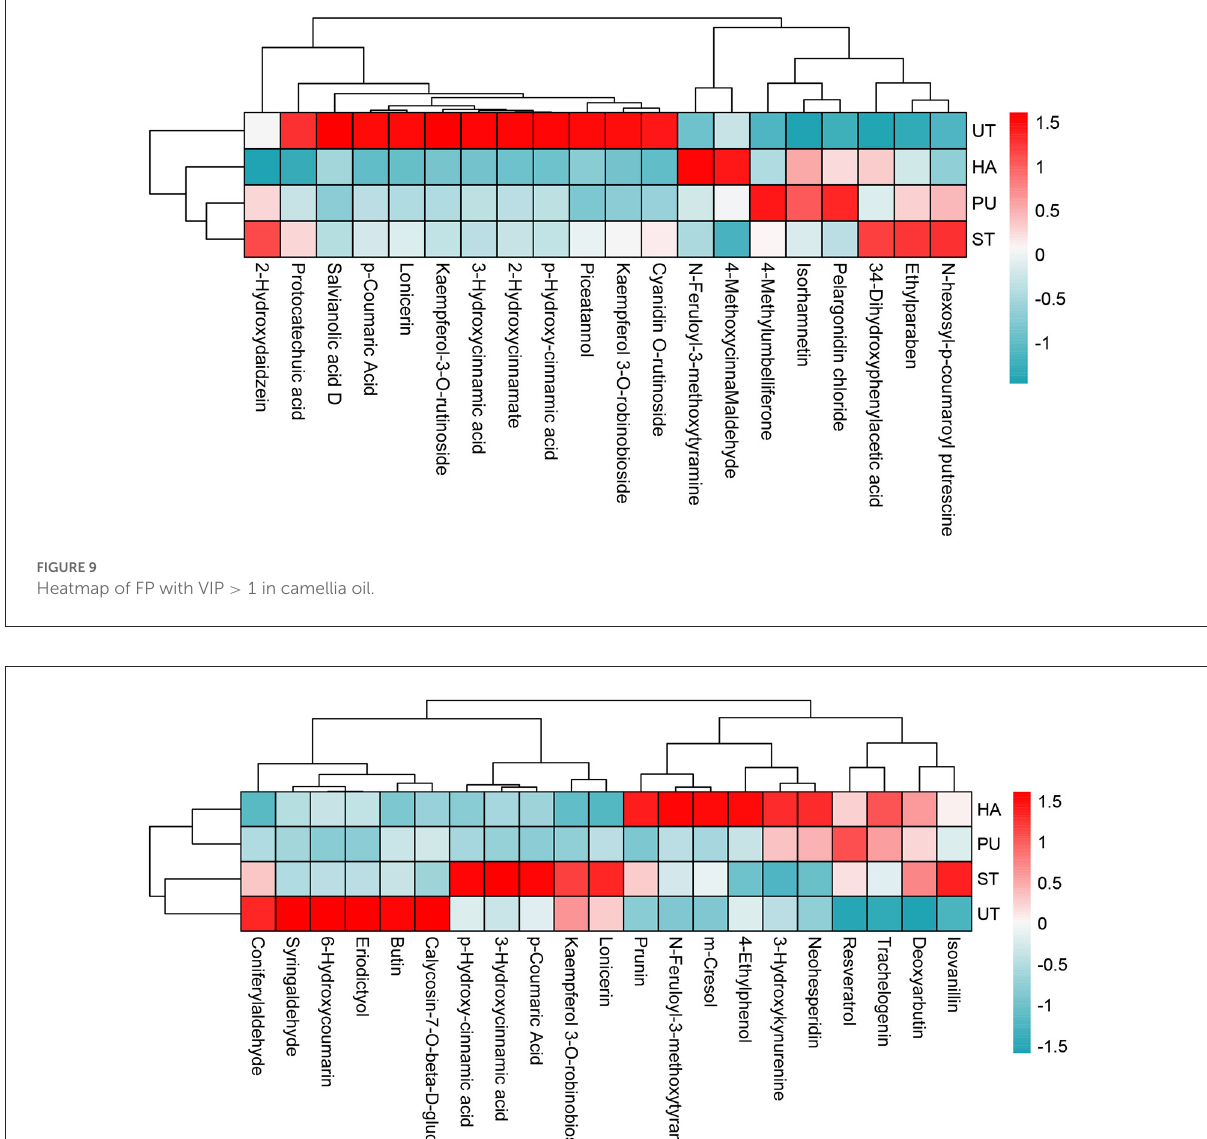
were both relatively low, they contributed about 20% of TP, respectively. Zhang et al. (30) found that the most abundant phenolic forms in camellia oil were glycosylated, esterified and insoluble, and the least abundant was free form. Luo and Fei (12) found that the average TP content of camellia species is similar both in the kernels and in the shells, and the content order of the three forms of phenolics was FP > IBP > CP, however, FP content in camellia seed oil was the